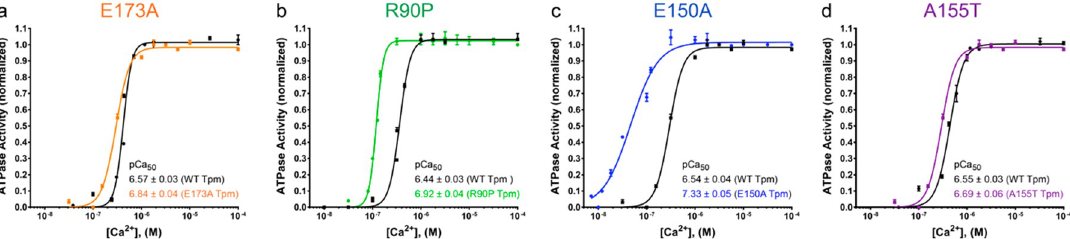
Figure 5. The effect of the Tpm mutations E173A ( a ), R90P ( b ), E150A ( c ) and A155T ( d ) on actin-S1 ATPase activity. Ca 2+ -dependence for the ATPase activity for fully regulated reconstituted thin filaments is shown. The error bars indicate the average SD data for each sample were fitted to the Hill equation using GraphPad Prism 5 software, and the average pCa 50 values were obtained from the fitted curves. The experimental conditions are described in Section 4.